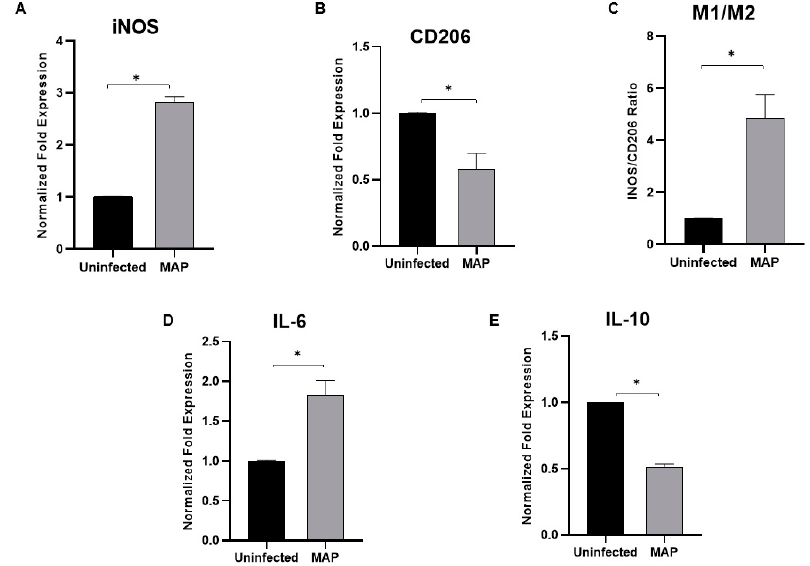
Figure 6. E ff ect of MAP infection on macrophage polarization and phenotypic response. THP-1-derived Figure 6. Effect of MAP infection on macrophage polarization and phenotypic response. THP-1- macrophages were infected with MAP (UCF 4, 10 7 CFU / mL) for 24 h. Expression levels of iNOS derived macrophages were infected with MAP (UCF 4, 10 7 CFU/mL) for 24 h. Expression levels of ( A ), CD206 ( B ), IL-6 ( D ), and IL-10 ( E ) were measured using RT-PCR. M1 / M2 ratio was determined iNOS ( A ), CD206 ( B ), IL-6 ( D ), and IL-10 ( E ) were measured using RT-PCR. M1/M2 ratio was by calculating the expression ratio of iNOS / CD206 ( C ). All experiments were performed in triplets. Data are shown as mean ± SD, and significance is considered as * p < 0.05.